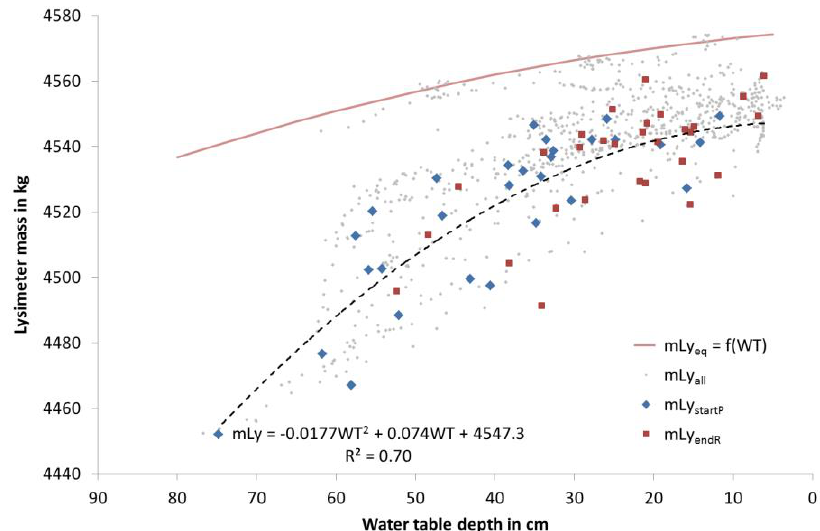
Figure 6. Absolute mass of the lysimeter under quasi-equilibrium conditions (mLy eq = f(WT)) and under dynamic conditions at the beginning of the rainfall events (mLy startP ) and at the end of runoff processes (mLy endR ). The regression curve mLy is based on the data containing both mLy startP and mLy endR . The small grey dots are mean daily lysimeter mass on days not selected for this investigation (mLy all ).